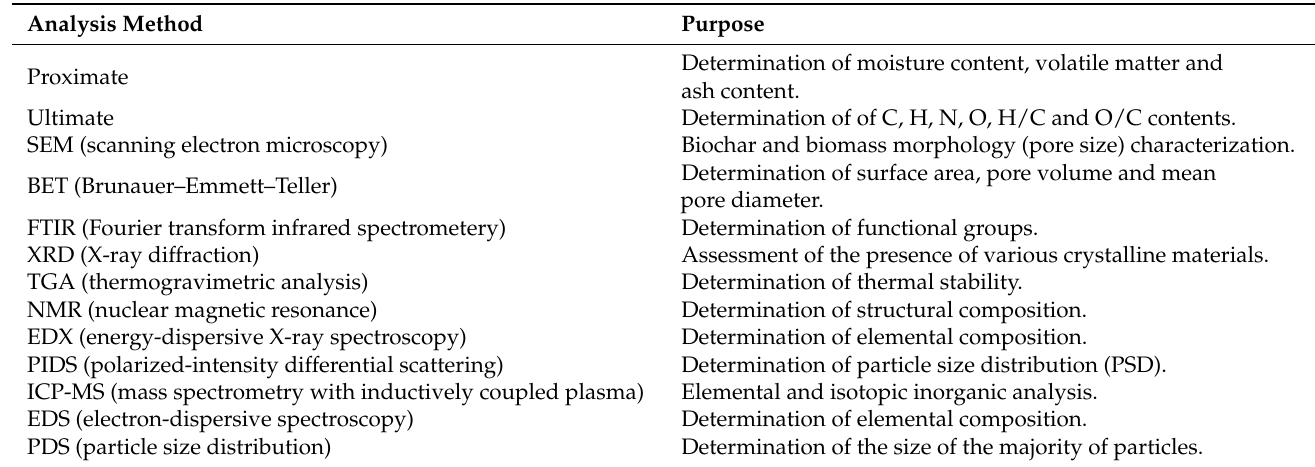
Table 2. Biomass and biochar categorization analyses according to their